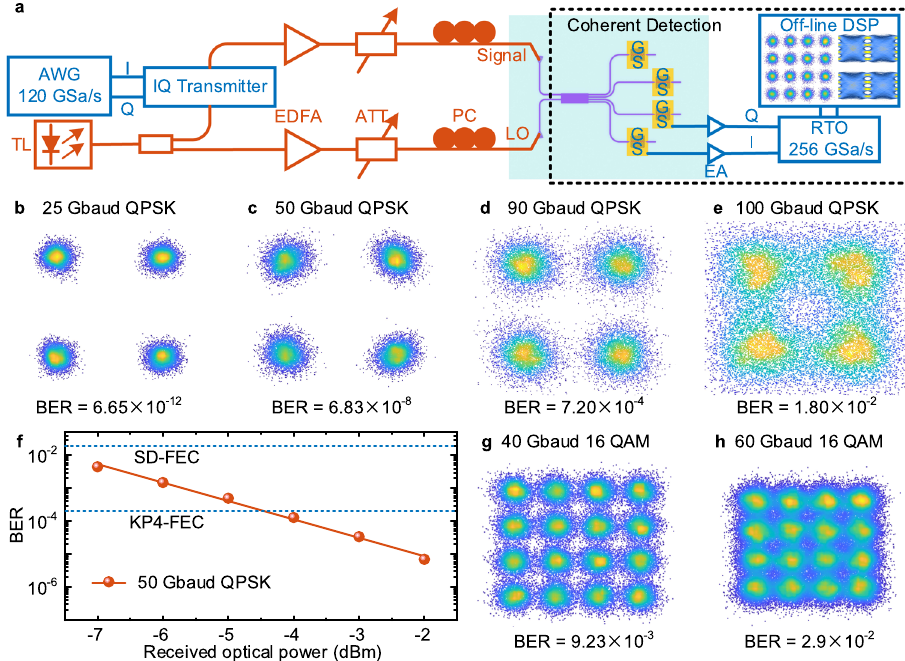
Fig. 5 Experimental demonstration of coherent detection. a Measurement setup for the coherent detection. b – e Constellation diagrams of 25 Gbaud ( b ), 50 Gbaud ( c ), 90 Gbaud ( d ), and 100 Gbaud ( e ) QPSK signals. f Measured BERs versus the received optical power for 50 Gbaud QPSK signal. SD: